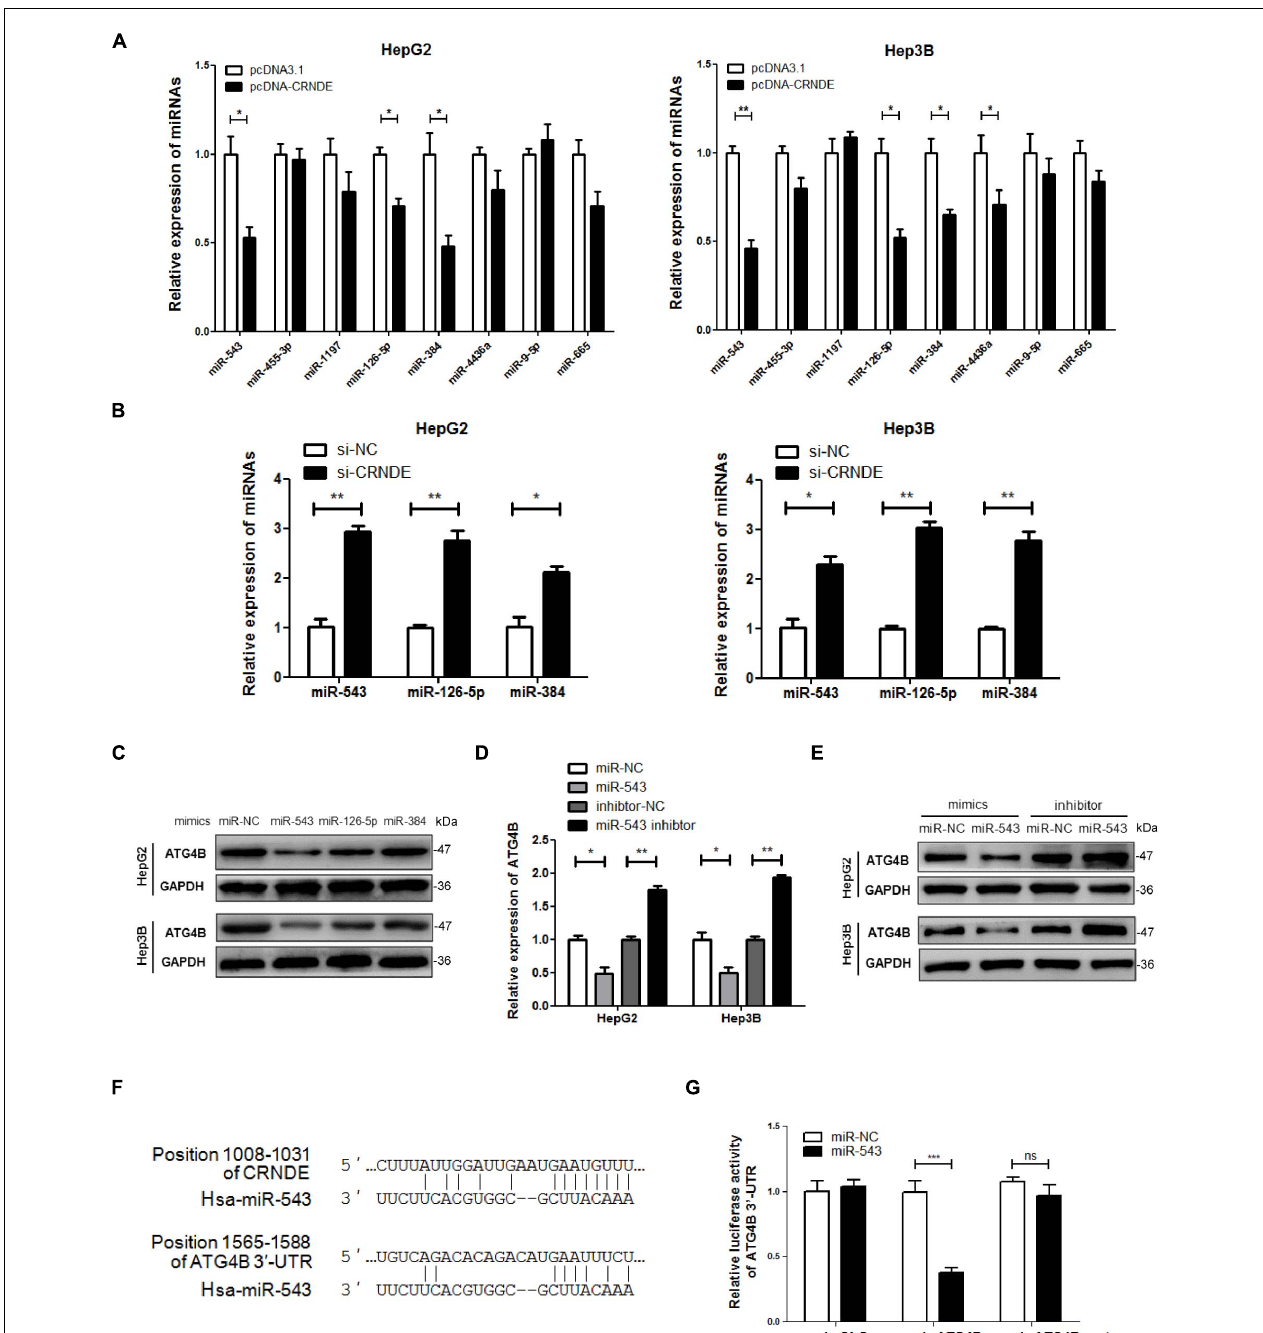
FIGURE 4 | miR-543 downregulates ATG4B by targeting its 3 (cid:48) -UTR. (A,B) HepG2 and Hep3B cells were transfected with pcDNA-CRNDE (or pcDNA3.1) (A) or si-CRNDE (or si-NC) (B) for 24 h, then the indicated miRNAs were analyzed by qPCR. (C) HepG2 and Hep3B cells were separately transfected with the mimics of the three candidate miRNAs (or miR-NC) for 24 h, then ATG4B protein level was measured by Western blot. (D,E) HepG2 and Hep3B cells were transfected with miR-543 mimics (or miR-NC) or inhibitor (or inhibitor-NC) for 24 h, then the levels of ATG4B mRNA and protein were separately detected by qPCR (D) and Western blot (E) . (F) The predicted binding sites of miR-543 in CRNDE and 3 (cid:48) -UTR of ATG4B mRNA. (G) HepG2 cells were co-transfected with the luciferase reporter plasmid pmir-ATG4B (or pmir-ATG4B-mut, or pmirGLO) and miR-543 mimics (or miR-NC) for 24 h. Then the luciferase activities were determined by dual-luciferase reporter assay. The activity of firefly luciferase was normalized against that of rennilla luciferase, and the result was shown as relative luciferase activity. miR-NC: control mimics; inhibitor-NC: control inhibitor; pmir-ATG4B: reporter vector of 3 (cid:48) -UTR of ATG4B mRNA; pmir-ATG4B-mut: reporter vector of mutant 3 (cid:48) -UTR of ATG4B mRNA; pmir-GLO: pmir-GLO vector; pcDNA-CRNDE, pcDNA3.1, si-CRNDE and si-NC were the same as the description in Figure 1 ; ns, no significance; * P < 0.05; ** P < 0.01; *** P < 0.001.